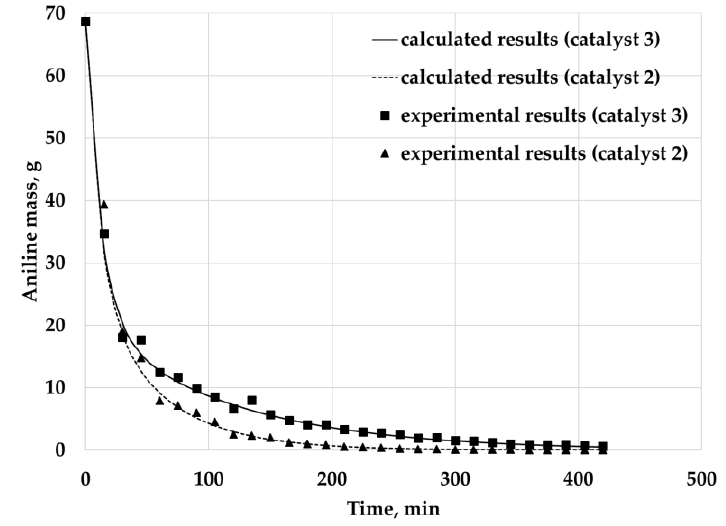
Figure 19. Comparison of experimental and calculated data.